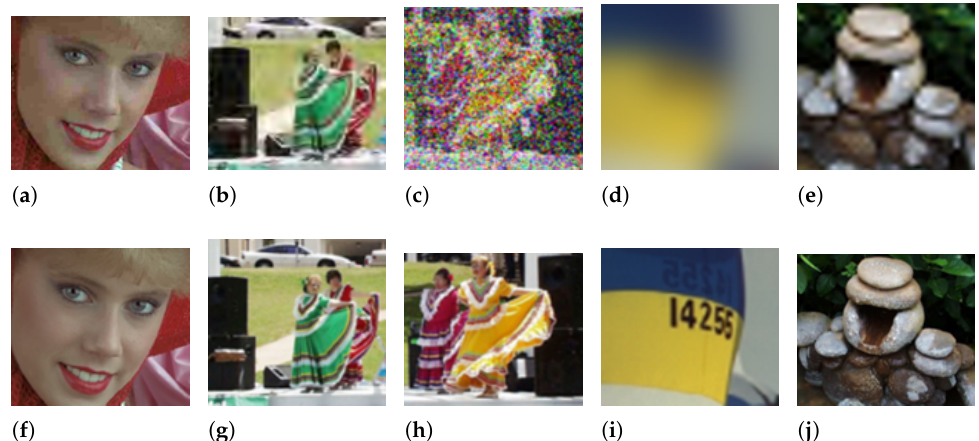
Figure 4. Corruption from the LIVE dataset. The corruption is performed on the entire image. The cropped noisy and ground truth pair image is shown in ( a – j ). The noisy image is in ( a , b ), while ( f – j ) is the respective ground truth image. The noisy images consist of ( a ) JPEG2000 compression, ( b ) JPEG compression, ( c ) white noise, ( d ) Gaussian blur, and ( e ) the fast-fading Rayleigh channel. In order to quantify the amount of loss between two curves, a cost function is needed to measure the Area Under the Curve (AUC) of the blue (ground truth) and red (noisy) curve. The greater the area, the greater the loss of the latent noisy image is. The loss function we chose to use was the Canberra distance. The Canberra distance is the measurement of the distance between the two curves. The formula for the Canberra distance is shown in Equation (5). The Canberra distance was chosen because it provides a bounded value from 0 to 1 for each extracted